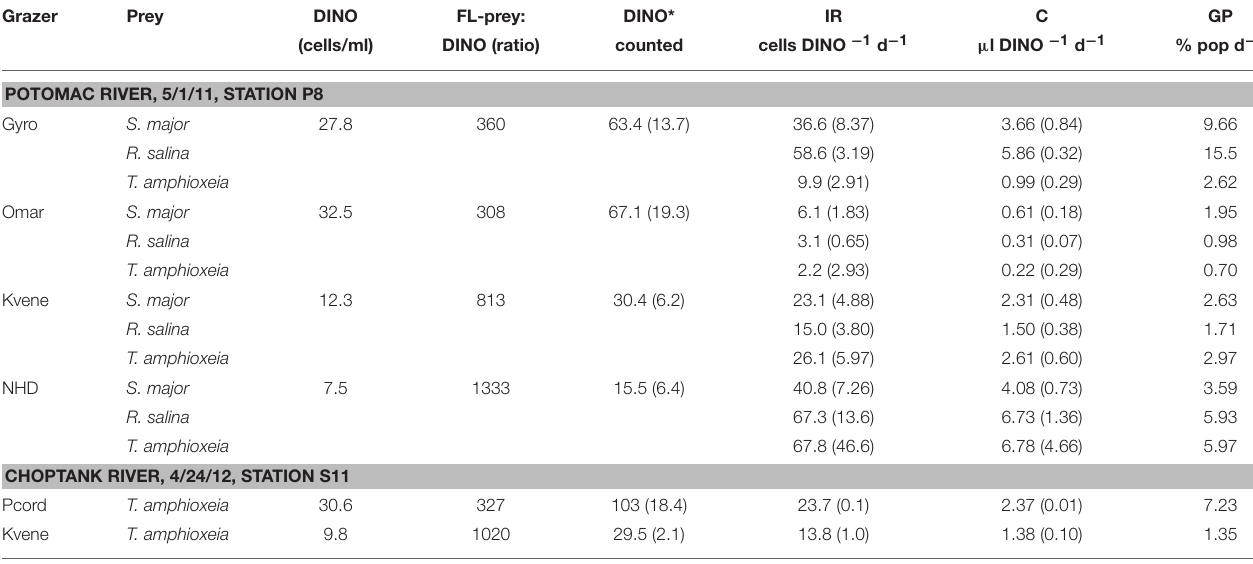
TABLE 4 | Grazing rates of dinoflagellates (DINO) in Chesapeake Bay Tributaries on the fluorescently labeled (FL) cryptophytes Storeatula major , Rhodomonas salina , and Teleaulax amphioxeia . Grazer